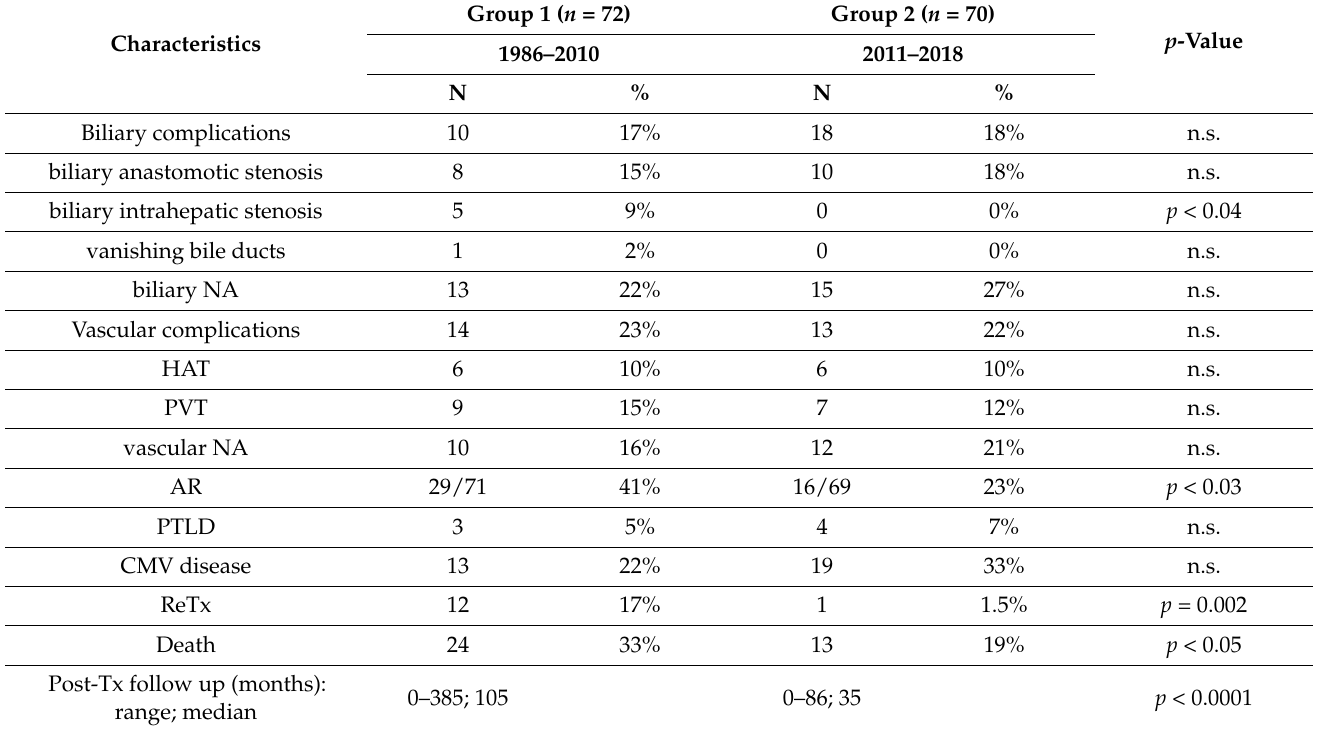
Table 5. Post-LT follow-up of 72 pts transplanted before 2011 (Group 1) and of 70 pts transplanted since 2011 (Group 2). Data corrected for availability (removal of missing data).